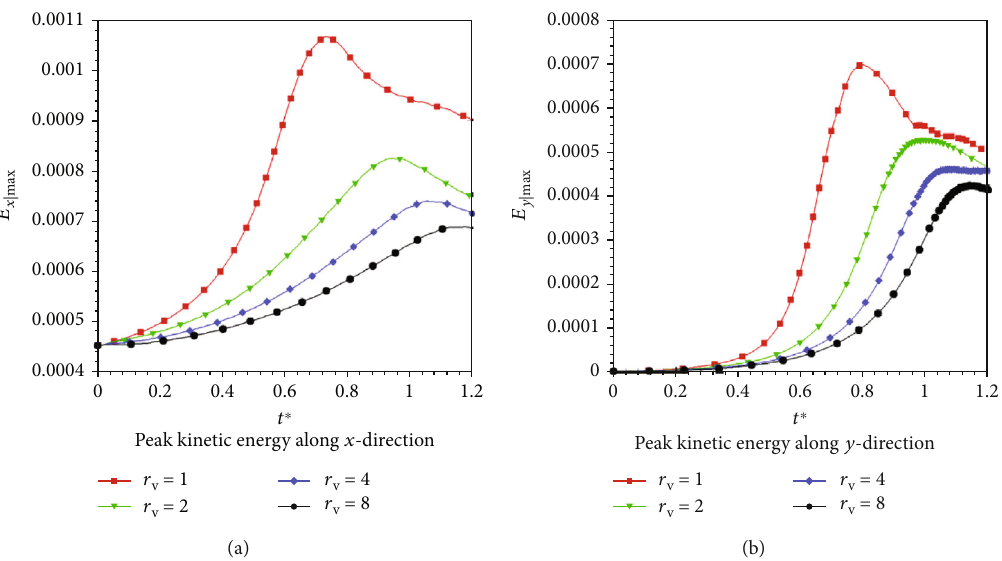
Figure 5: Temporal evolutions of the peak kinetic energy for di ff erent viscosity ratios.